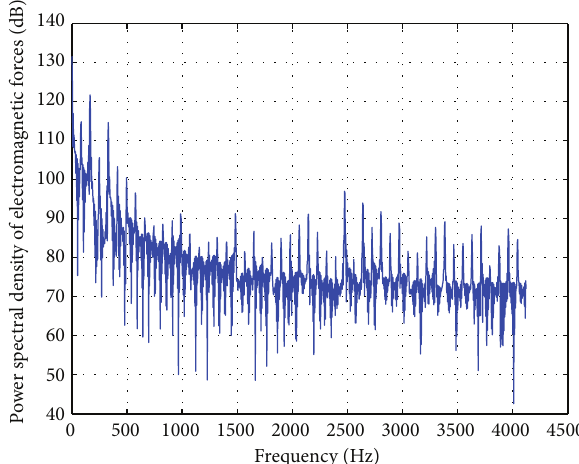
Figure 4: Stress direction of stator tooth of axial flux PMSM stator system of axial flux